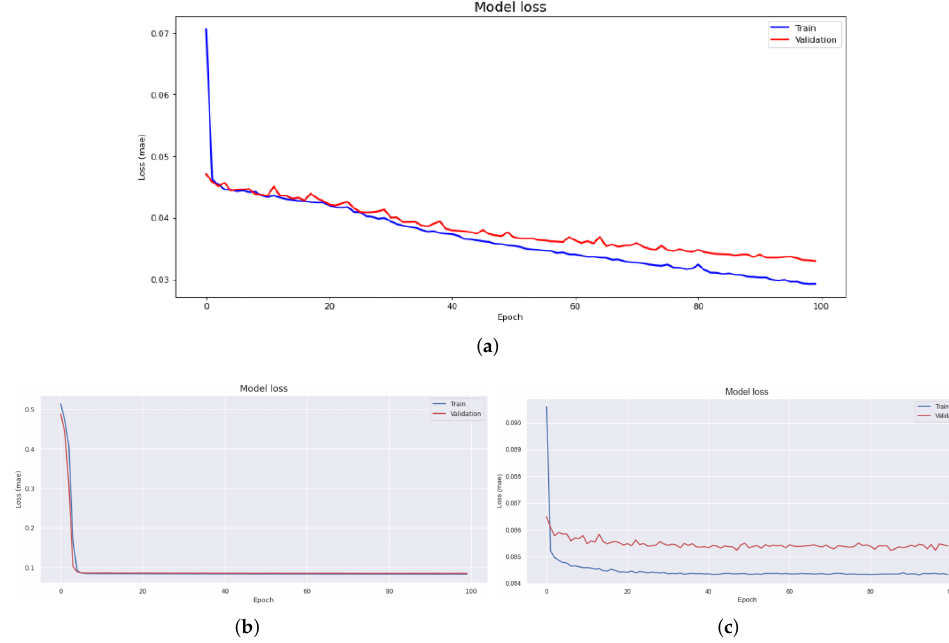
Figure 14. The results of using the Wavelet transformed data., the loss graph ( a ) result of using the convolutional auto-encoder, ( b ) result of using the auto-encoder LSTM, and ( c ) result of using the auto-encoder.